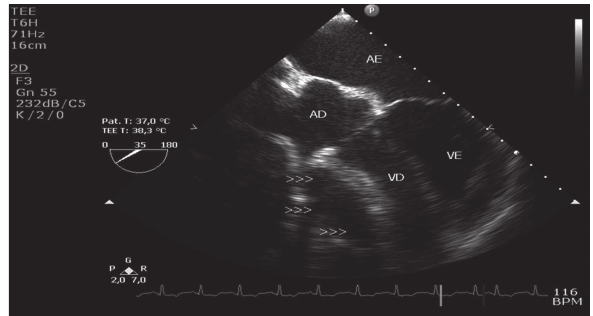
Fig. 1 – Imagem ao ecocardiograma transesofágico demonstrando compressão extrínseca das câmaras direitas, com desvio do septo interventricular para a esquerda em decorrência do cisto pericárdico (setas). AD: átrio direito; VD: ventrículo direito; AE: